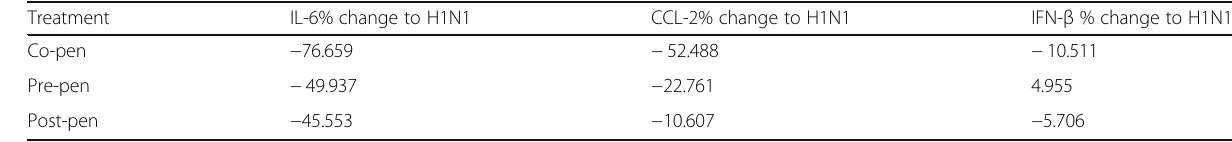
Table 2 Cytokines protein percentages of changes in MDCK culture supernatants at 48 h treatment Treatment IL-6% change to H1N1 CCL-2% change to H1N1 IFN- β % change to H1N1 Co-pen − 76.659 − 52.488 − 10.511 Pre-pen − 49.937 − 22.761 4.955 Post-pen − 45.553 − 10.607 −